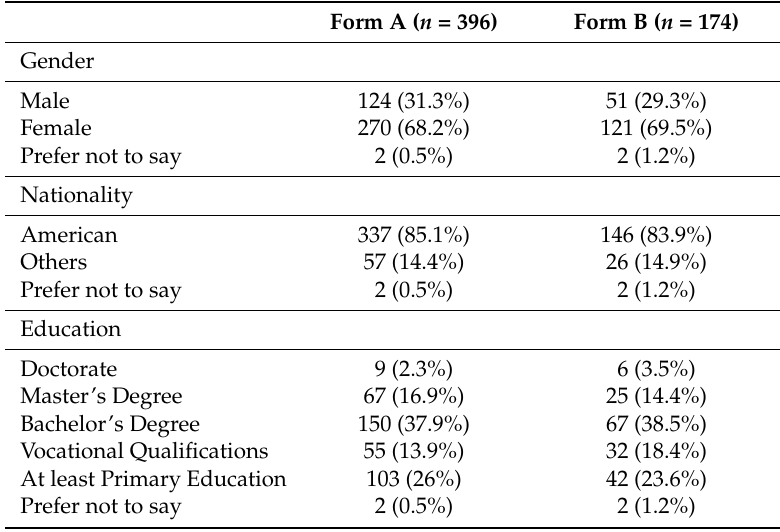
Table 3. Demographics comparison between Form A and Form